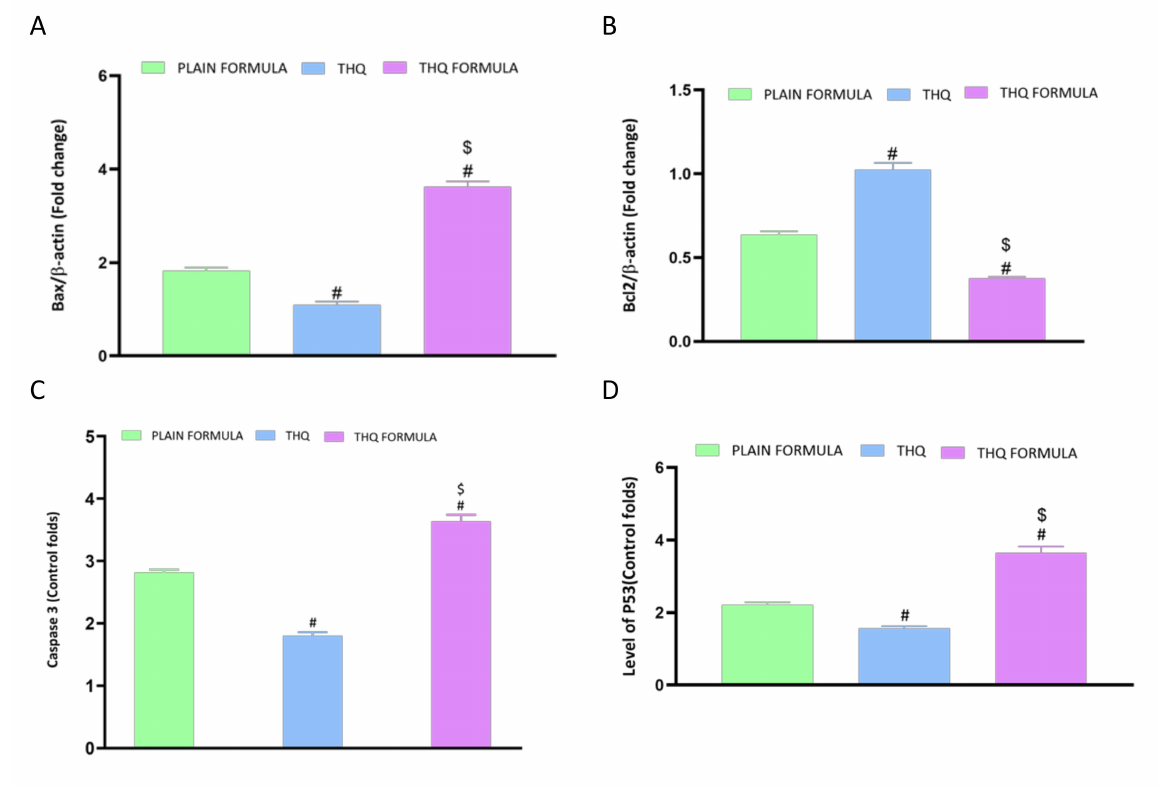
Figure 7. Effect of the THQ formula on mRNA expression of ( A ) Bax, ( B ) Bcl-2, ( C ) caspase-3, and ( D ) p53. Data are presented as mean ± SD ( n = 3). #: Significantly different from plain formula at p < 0.05. $: Significantly different from THQ at p < 0.05.